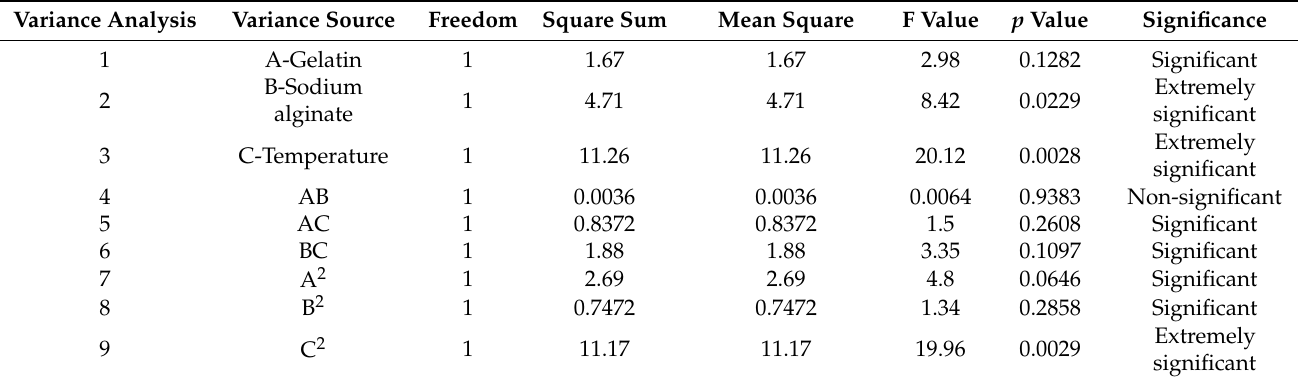
Table 3. Variance analysis of experiment